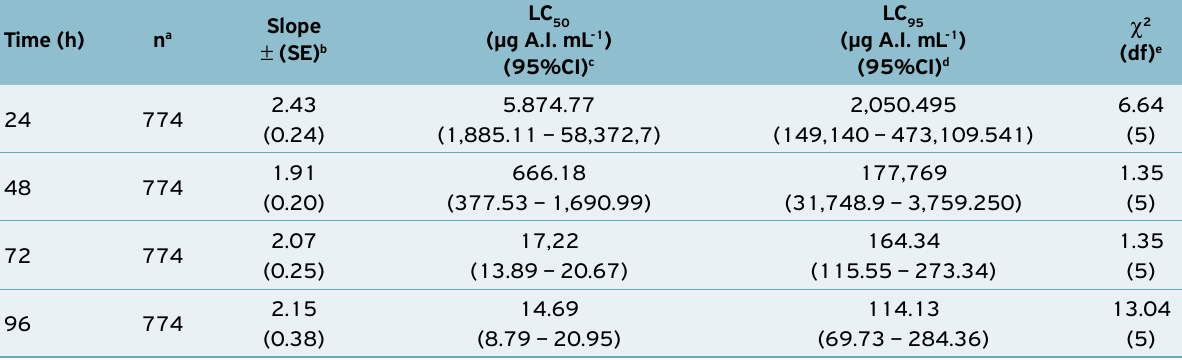
Table 3. Evaluation of mortality-time of C. includens (SUS) to